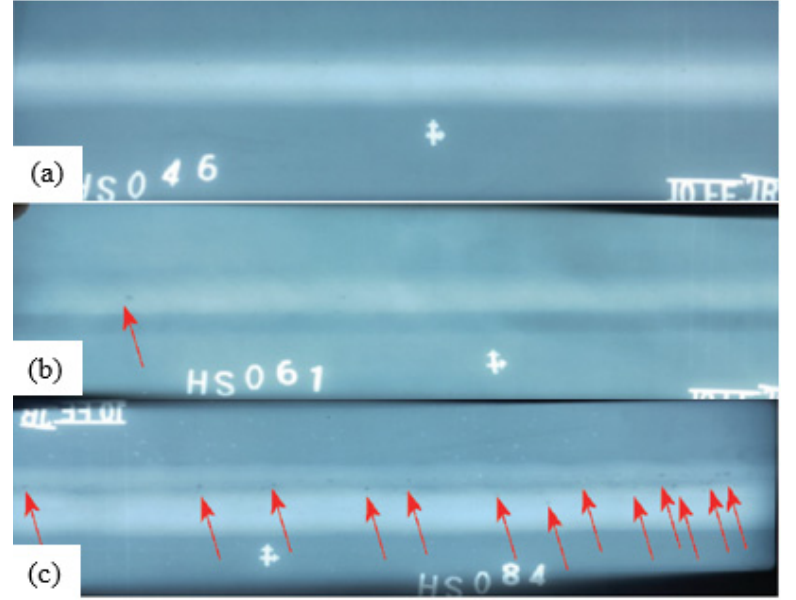
Figure 4. Effect of the nitrogen content in the welding wire on the porosity. ( a ) 0.46% N in welding wires ( b ) 0.6% N in welding wires ( c ) 0.84% N in welding wires. Reprinted with permission from ref. [20]. Copyright 2021, Acta Armamentarii.